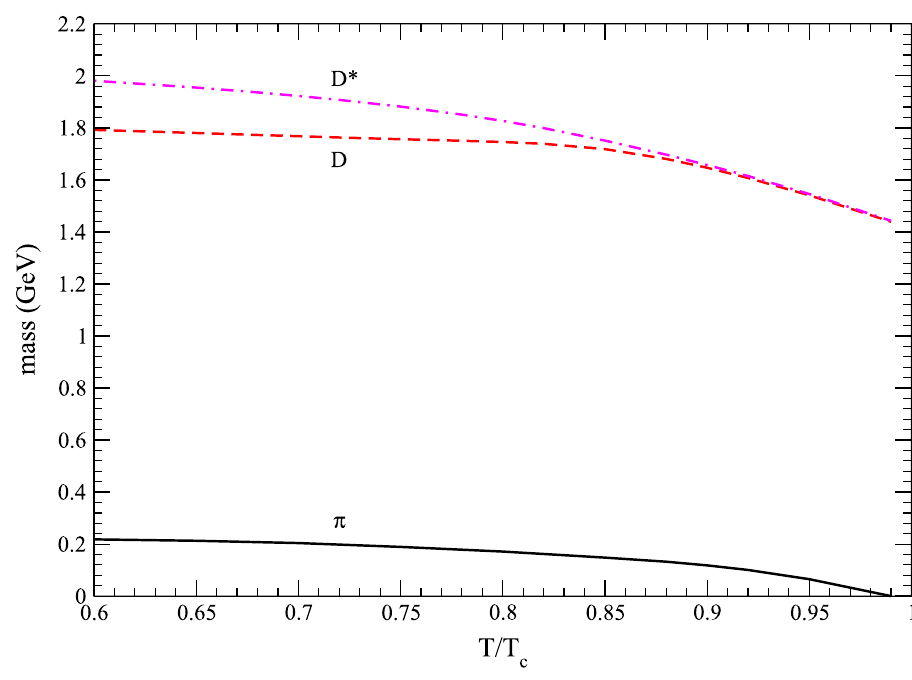
Fig. 3 π , D , and D ∗ masses as functions of T / T